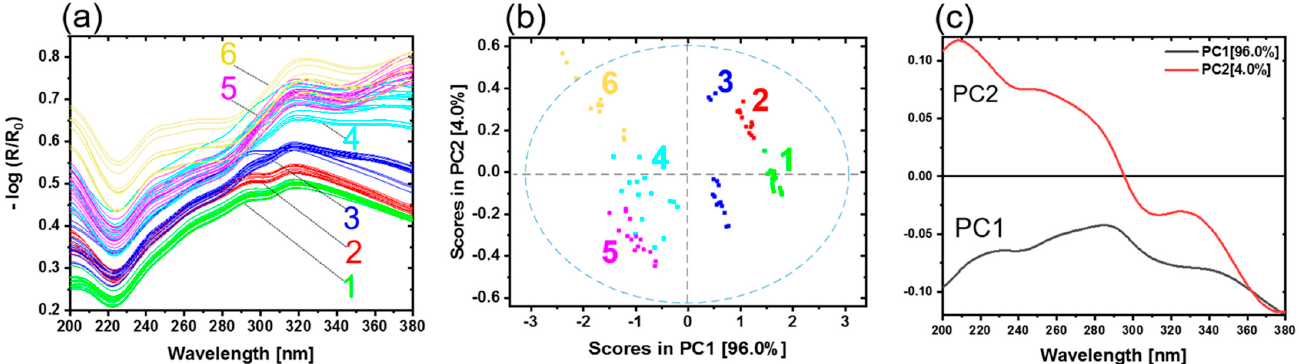
Figure 4. ( a ) UV reflectance spectra of copper sheets. Copper with initial condition type 1 (green), 2 (red), 3 (blue), 4 (light blue), 5 (pink) and 6 (yellow) represent the oxidation layer thicknesses 0 nm, 4 nm, 8.3 nm, 14 nm and 21.1 nm, respectively. ( b ) PCA with scores and ( c ) the corresponding loadings plot.